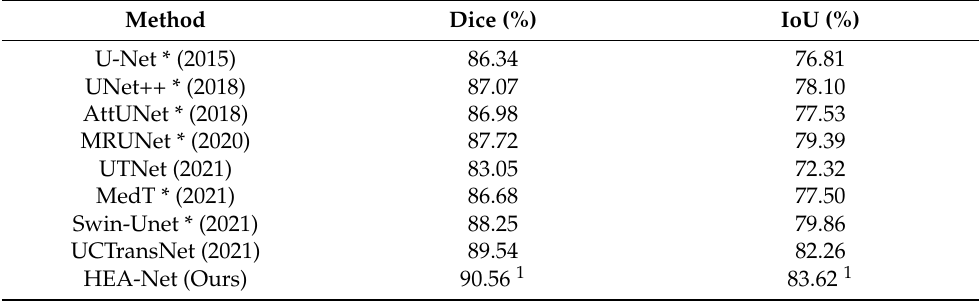
Table 1. Comparative experimental results on GlaS datasets. Network results with “*” are derived from [31]. The superscript “1” indicates the best experimental result.